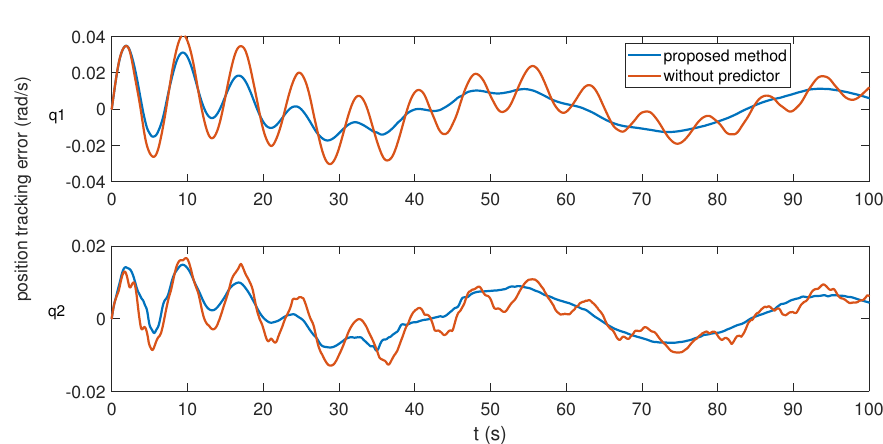
Figure 8. Compared results of position tracking